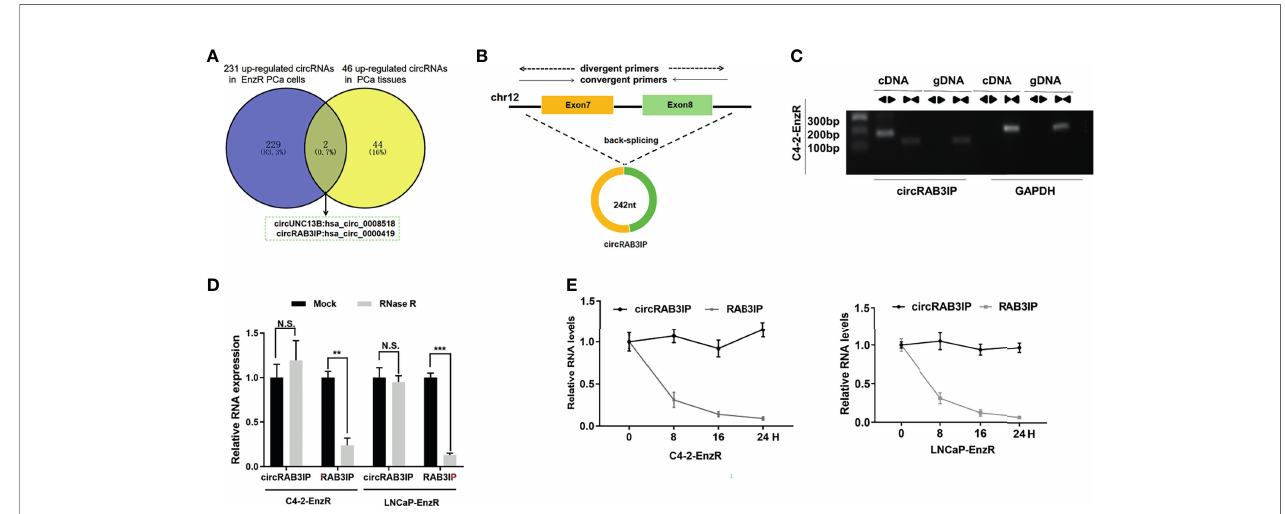
FIGURE 1 | (A) Analysis of circRNA microarray data (GSE118959) from EnzR PCa cells and RNA-seq data of 25 pairs of matched tumor and normal for PRAD samples by Josh et al. (B) Schematic diagram of the genomic location and splicing pattern of circRAB3IP. The divergent and convergent primers were designed to detect circRAB3IP and RAB3IP, respectively. (C) PCR was performed to detect the existence of circRAB3IP from cDNA and gDNA in C4-2-EnzR cells using divergent and convergent primers, respectively. (D) qRT-PCR was conducted to determine the abundances of circRAB3IP and linear RAB3IP mRNA in PCa cells treated with RNase R at the indicated time points. (E) The RNA expression levels of circRAB3IP and RAB3IP were detected by qRT-PCR after treatment with actinomycin D at the indicated time points. Data are presented as mean ± SEM. **P < 0.01, ***P < 0.001 compared with the controls. N.S., not signi fi cant compared with the